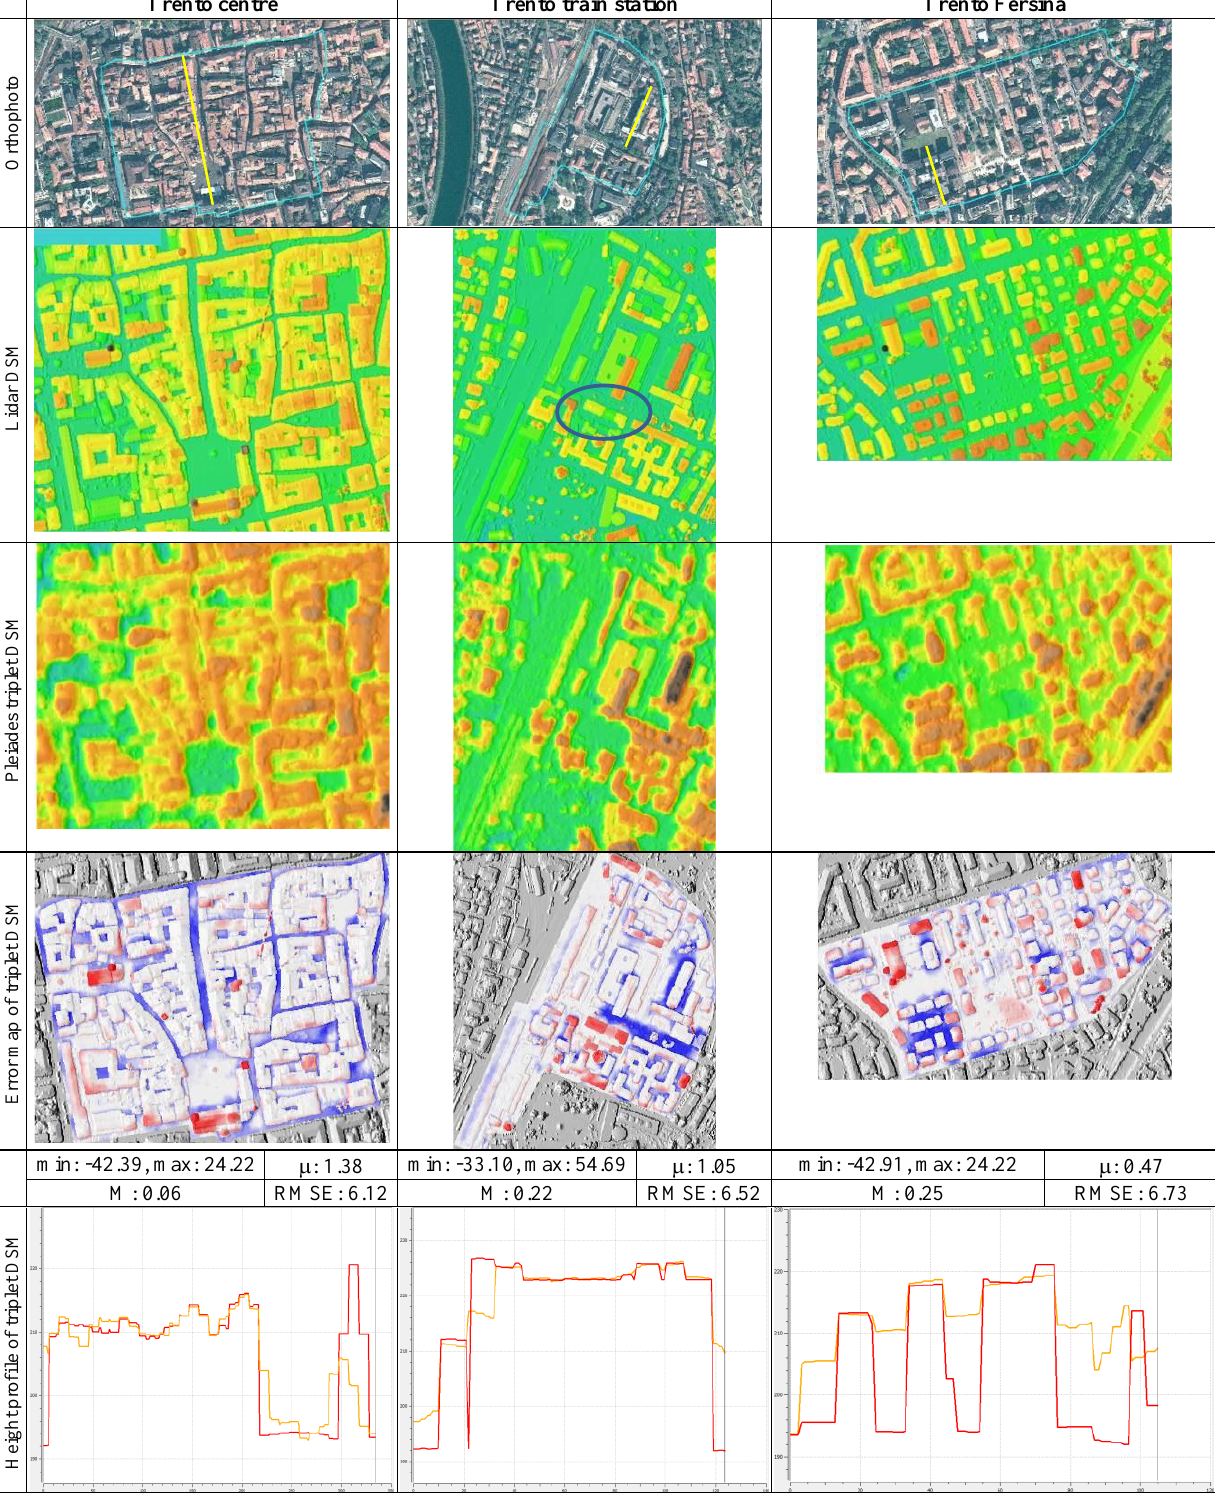
Table 3. Quality evaluation of Pleiades DSM with respect to the Lidar DSM: orthophoto with test areas contour (light blue) and profile transect (yellow), Lidar DSM, Pleiades DSM, error planimetric distribution, statistics (minimum, maximum, mean  , standard deviation  , median M, RMSE) and height profiles (red: Lidar, orange: Pleiades DSM). All values are in